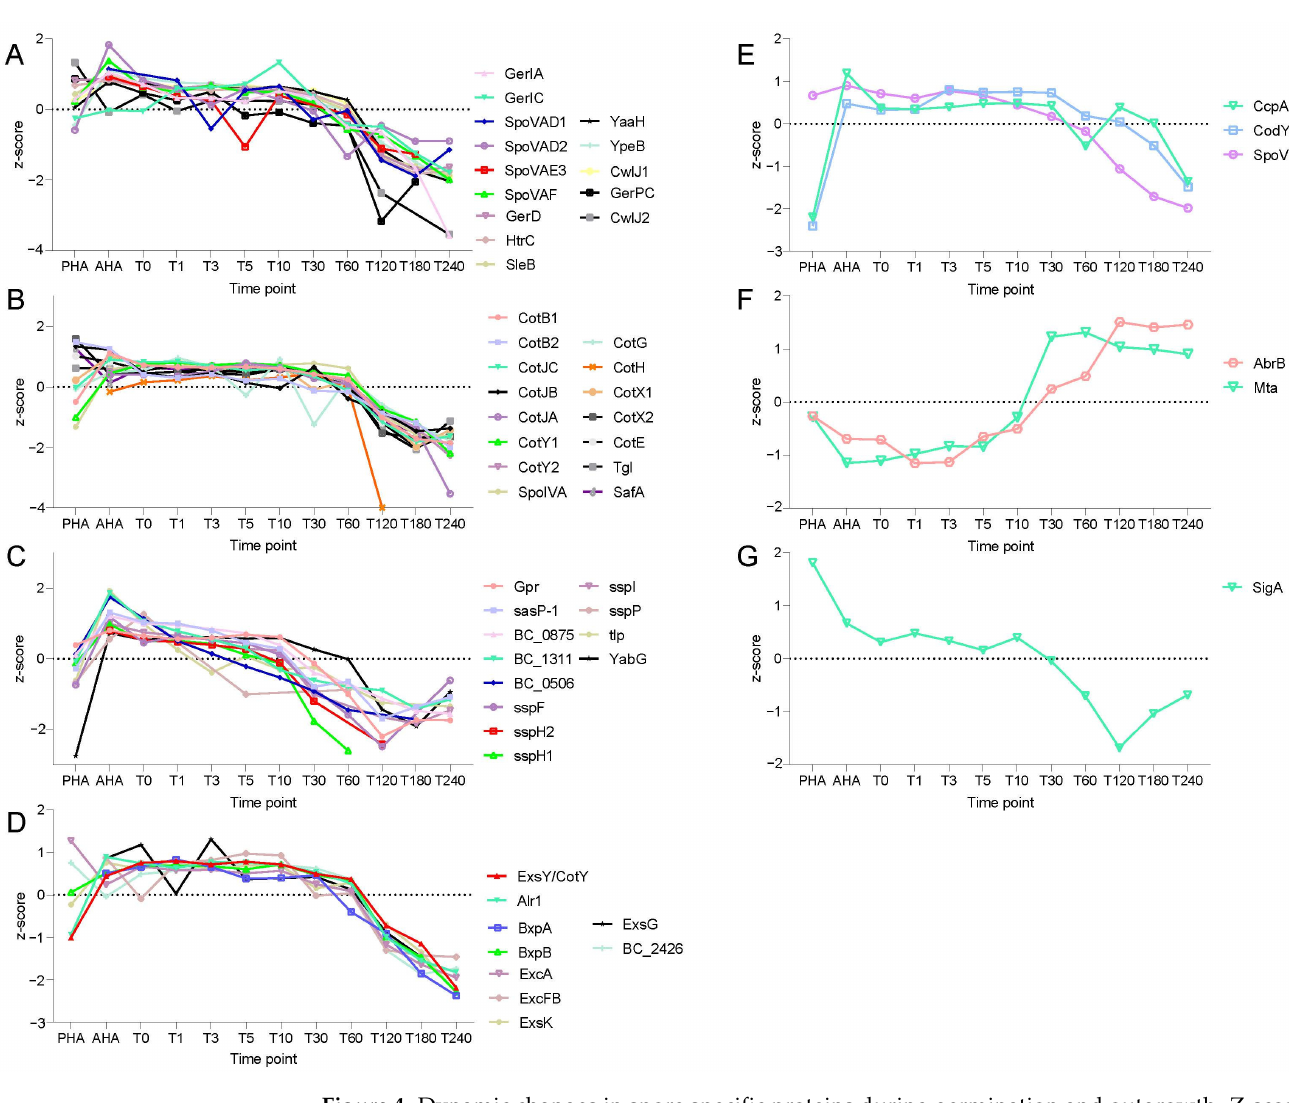
Figure 4. Dynamic changes in spore specific proteins during germination and outgrowth. Z-score profiles of the identified spore proteins across all of the times points are shown. ( A – D ) Identified germination pathway proteins, coat proteins, SASP, and exosporium proteins, respectively. ( E – G ) The abundance variations of conserved regulators at different time points. The Y axes display the z-scores transformed protein LFQ signal intensity and the x axes show the time points.